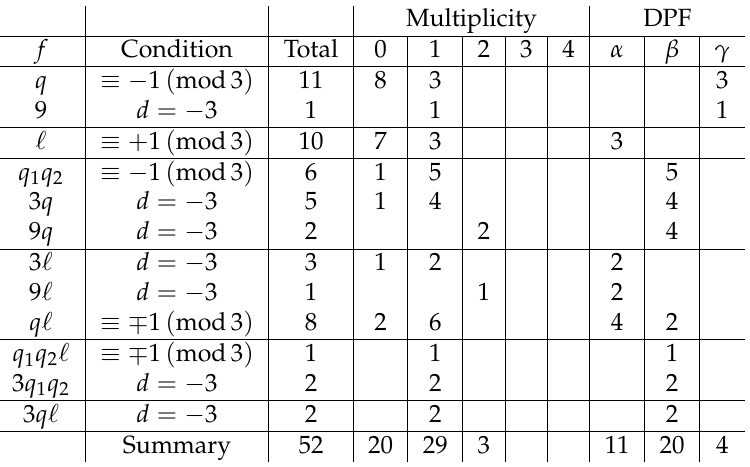
Table 2. Pure cubic discriminants in the range − 2 · 10 4 < d L = − 3 · f 2 < 0 Multiplicity DPF f Condition Total